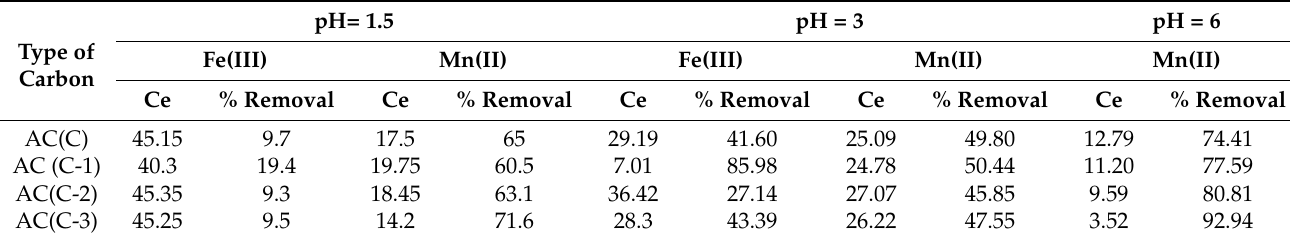
Table 2. Preliminary test for selection of adsorbent samples (C o = Fe(III) and Mn(II) = 50 mg/L, pH = 1.5, 3, and 6 respectively, time = 2 h, wt. = 0.05 g, agitation speed = 100 rpm and temp. 25 ◦ C). C e is the concentration of Fe(III) and Mn(II) at equilibrium.